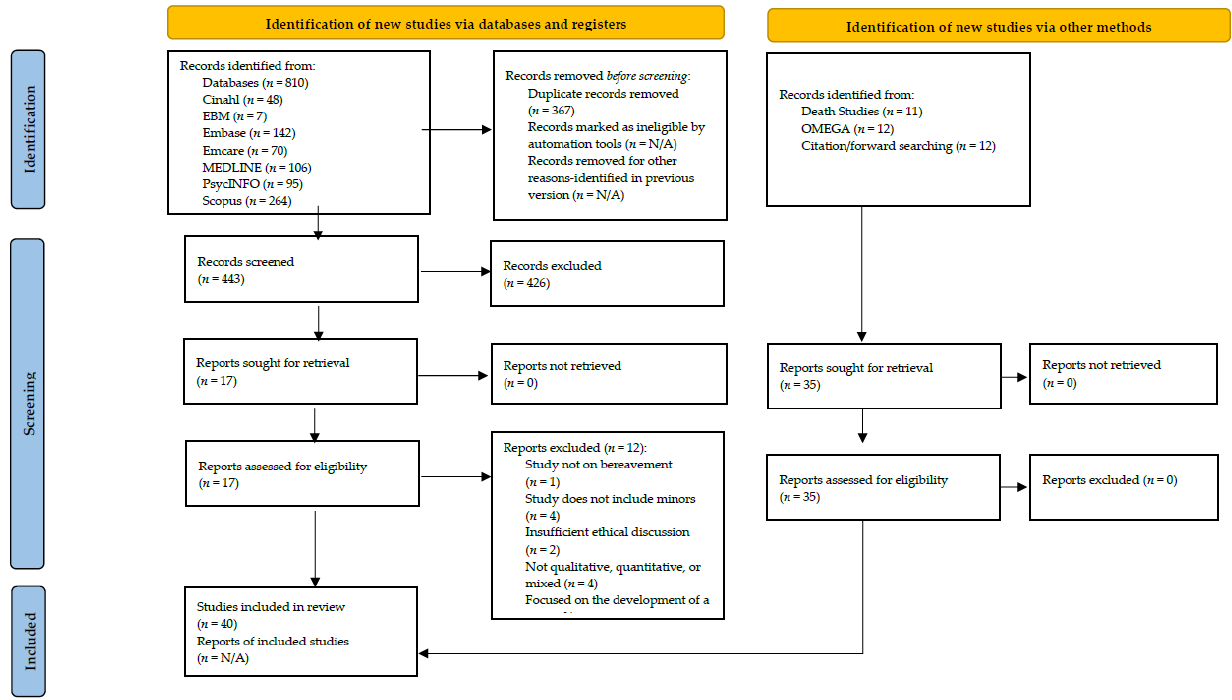
Figure 1. PRISMA flow diagram for peer-reviewed literature.